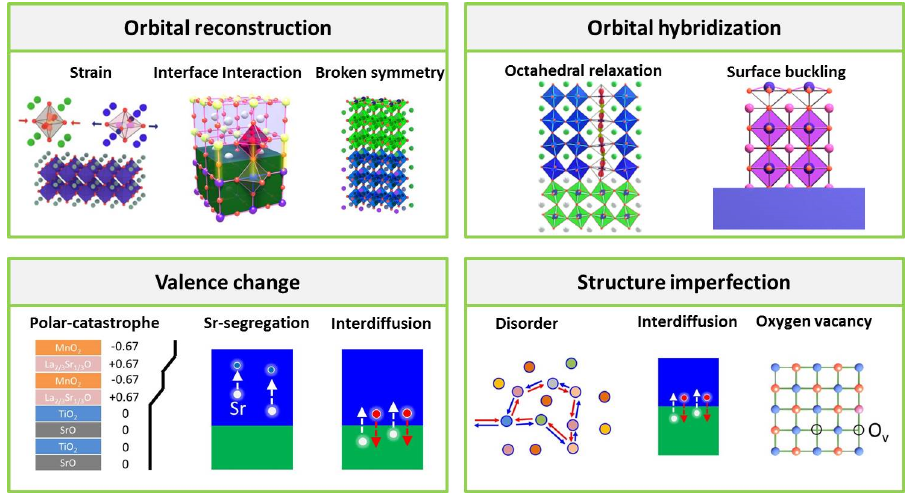
Figure 7. Proposed mechanisms for the origin of the dead layer in LSMO thin films.